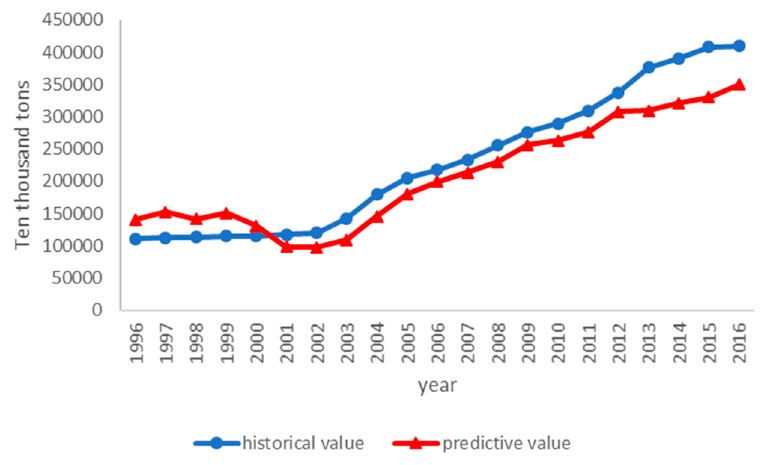
Figure 3. Historical and forecast values of China (cid:48) s energy consumption carbon emissions. Figure 3 . Historical and forecast values of China ′ s energy consumption carbon emissions .